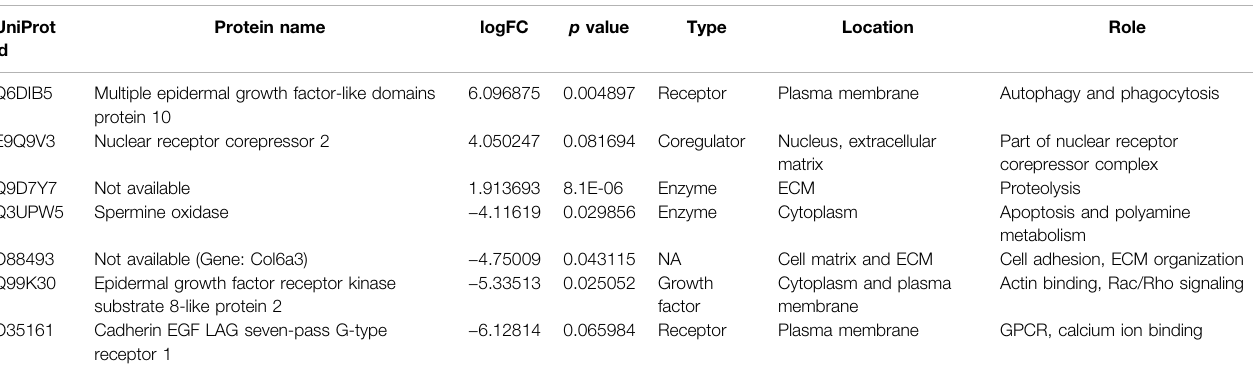
TABLE 1 | Dysregulated proteins found in 5-FU/LV treatment group versus saline treatment group.